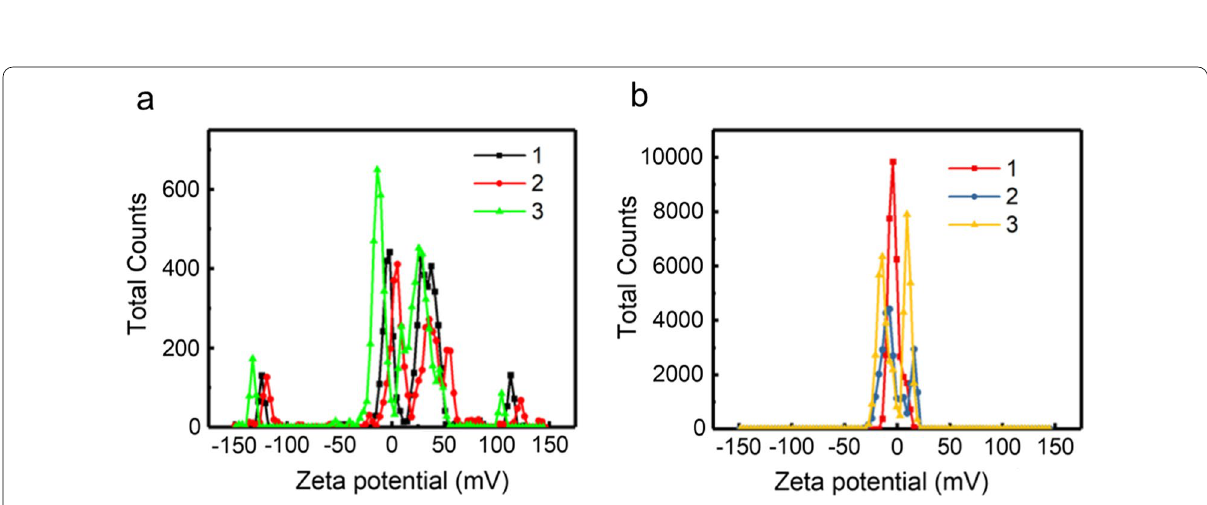
Fig. 3 Zeta potential of CDs ( a ) and CDFs ( b )